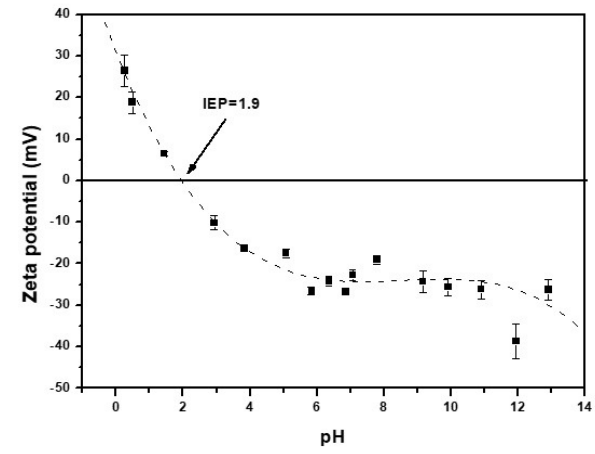
Figure 2. Zeta potential of CNF versus pH.